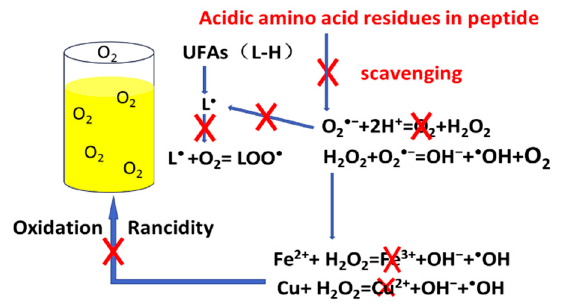
Figure 4. The possible mechanism of acidic amino acids in the peptide to resist oil oxidation. L-H stands for the unsaturated fatty acids in oil, L • represents the carbon-base radicals and LOO • represents the peroxyl radicals.